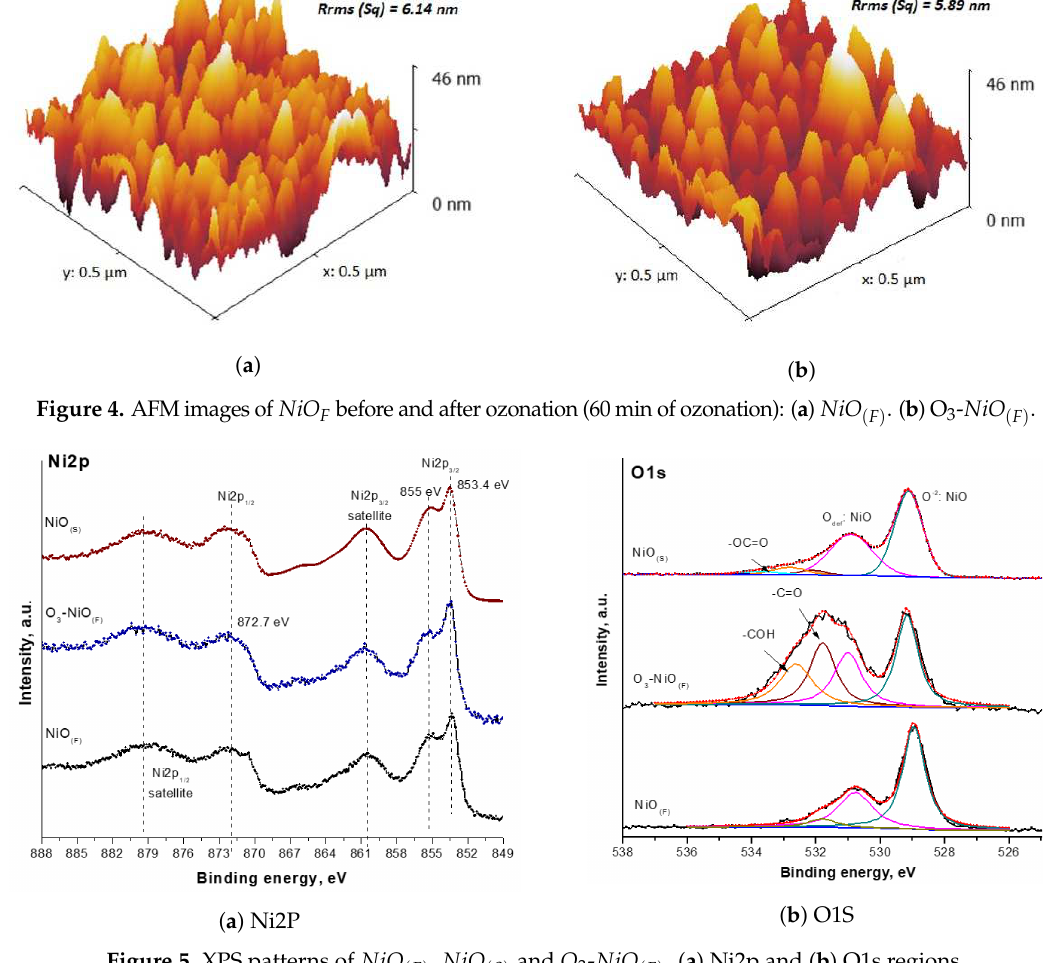
Figure 5. XPS patterns of NiO ( F ) , NiO ( S ) and O 3 - NiO ( F ) . ( a ) Ni2p and ( b ) O1s